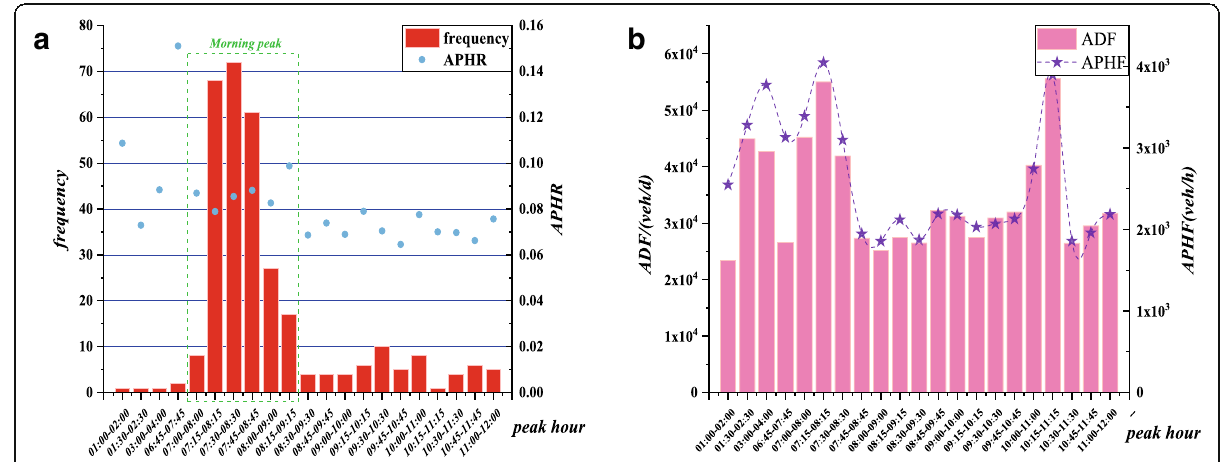
Fig. 6 Morning peak time characteristics, ( a ) peak hour distribution and APHR; ( b ) correlation between average peak hour flow and average daily total